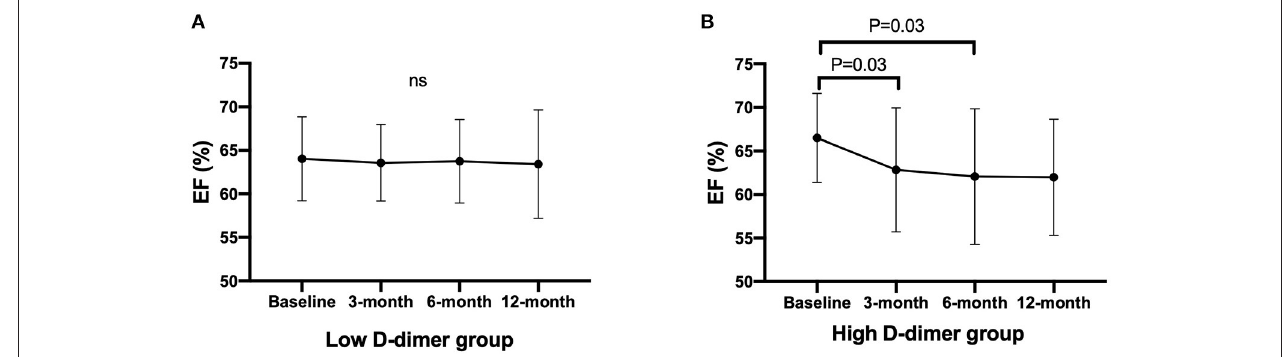
FIGURE 3 | Time-dependent changes in EF after chemotherapy. Data are expressed in mean with SD. Statistics is performed using Friedman’s test with Dunn’s multiple comparisons test. EF, ejection fraction. (A) Changes in EF in the low D-dimer group. (B) Changes in EF in the high D-dimer group. EF, ejection fraction.